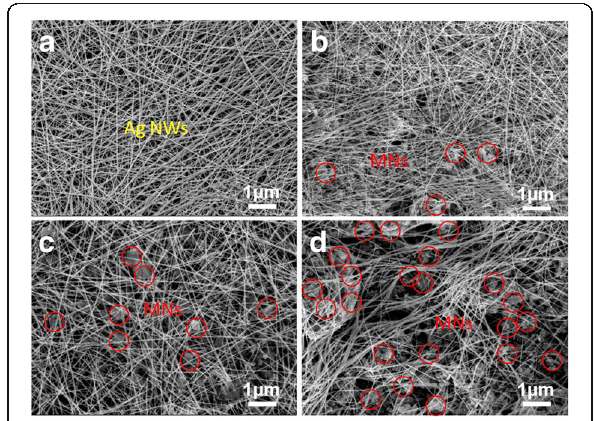
Fig. 3 a AgNWs & MNs in mass ratio of 1:0, b 5:1, c 2:1, and d